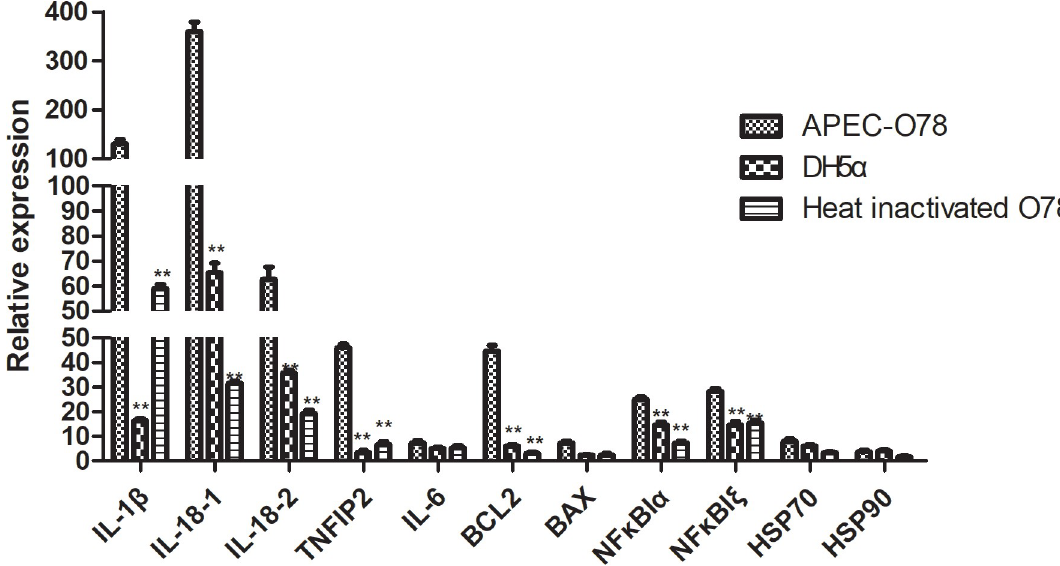
Fig 8. Changes in the expression levels of related immune resistance genes of CP II cells infected by APEC- O78. After DH5 α , APEC-O78 and heat inactivated APEC-O78 treated for 4 h with CP II cells, the expression levels of related immune resistance genes of CP II cells was detected by qRT-PCR. � P < 0.05 and �� P < 0.01 are significantly different from the DH5 α and heat inactivated APEC-O78 group.